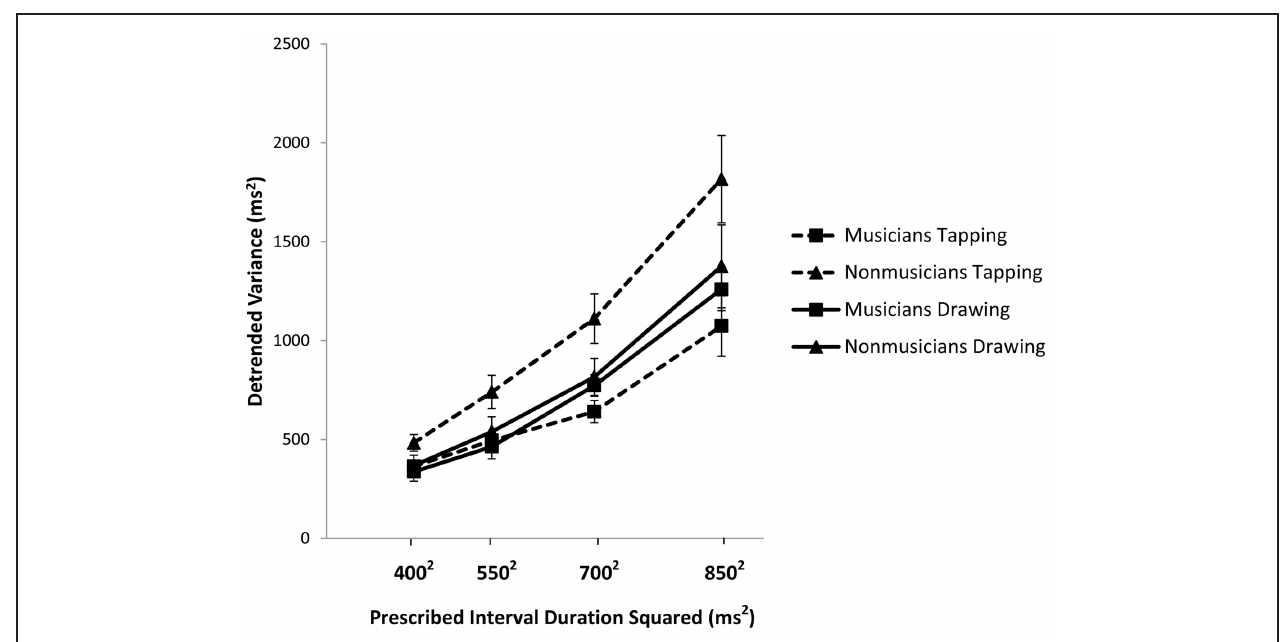
FIGURE 2 | Detrended variance of the Unpaced IRI plotted against the square of the prescribed interval duration and with standard error bars.